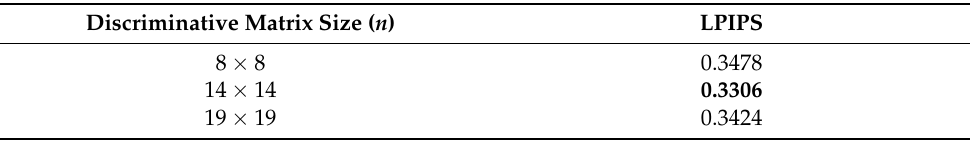
Table A3. Mean value of LPIPS for models with different discriminative matrix sizes, where n represents the size of the discriminative matrix. The best performance in